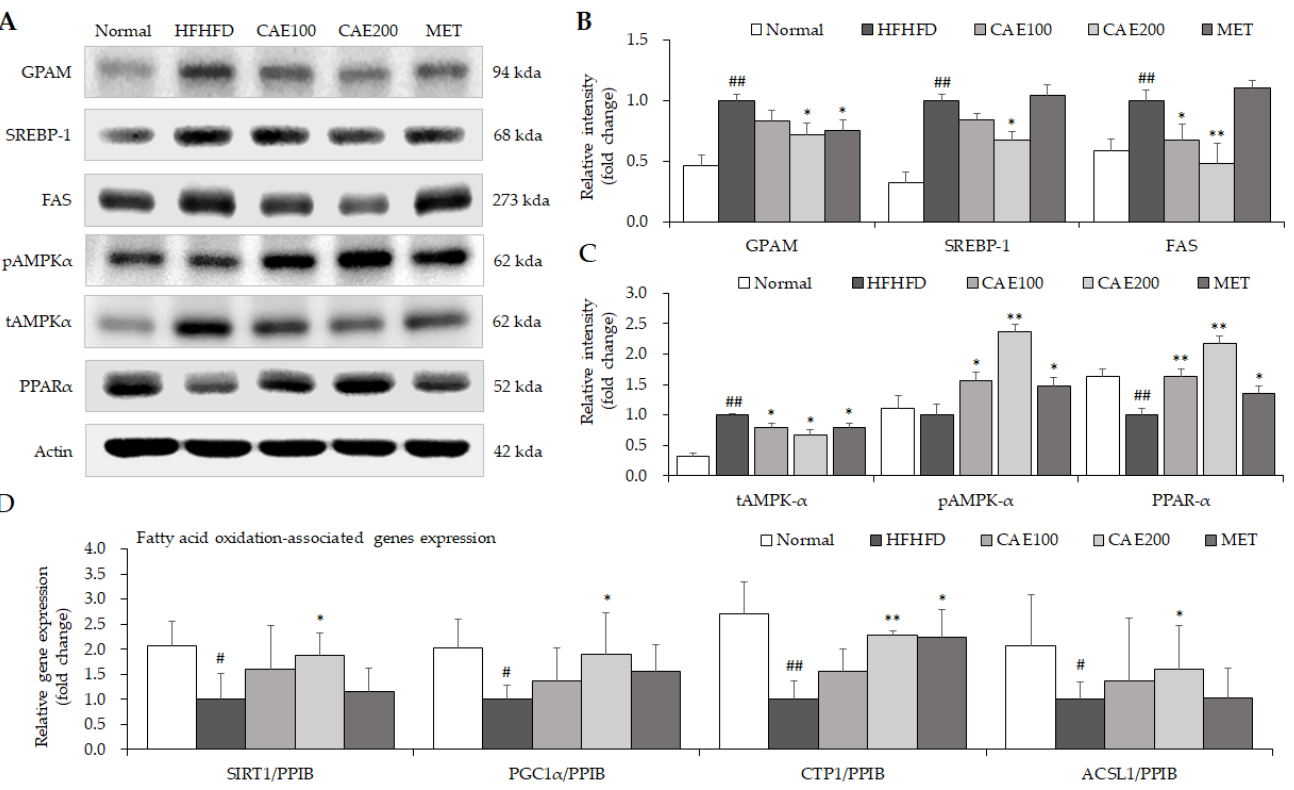
Figure 5. CAE ameliorated lipid metabolism through the alteration of lipid genesis and fatty acid oxidation. The levels of hepatic lipogenesis and fatty acid oxidation-related proteins were evaluated using Western blot ( A ) (n = 6). The relative intensity was calculated using ImageJ software for the comparison of fold change ( B , C ). The gene expression of fatty acid oxidation-related genes was determined via real-time PCR ( D ) (n = 6). # p < 0.05 and ## p < 0.01, as compared to normal group; * p < 0.05 and ** p < 0.01, as compared to HFHFD